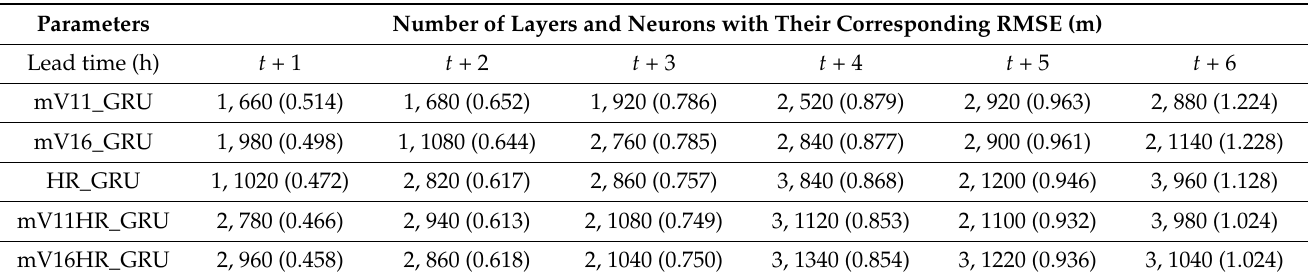
Table 4. Parameter calibration for the number of GRU layers and number of neurons in a GRU layer at the Guishandao buoy. Parameters Number of Layers and Neurons with Their Corresponding RMSE